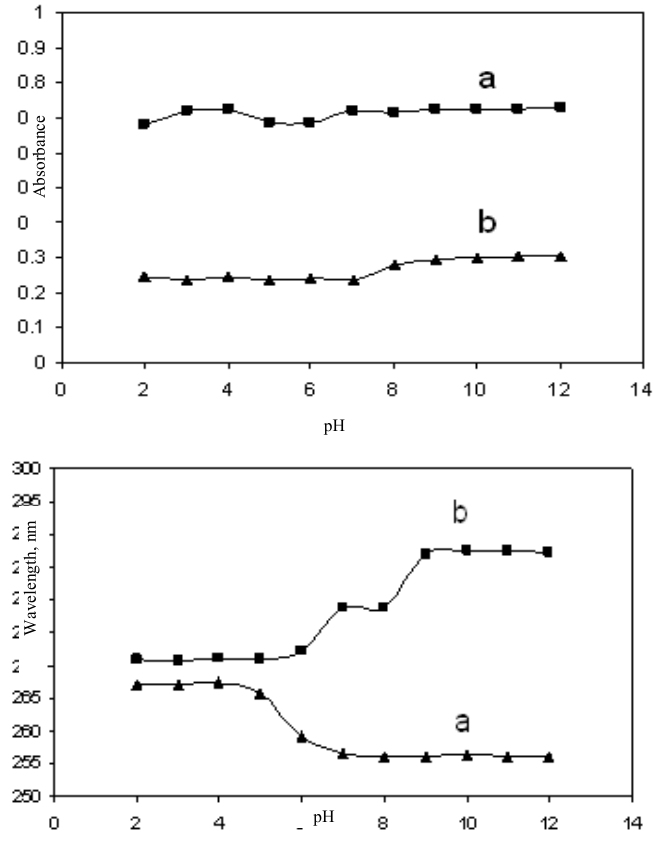
Figure 7. (A) Effect of pH on the maximum absorption spectra of sulfamethoxazole (a) and trimethoprim (b). (B) Effect of pH on the  of sulfamethoxazole (a) and trimethoprim (b). max